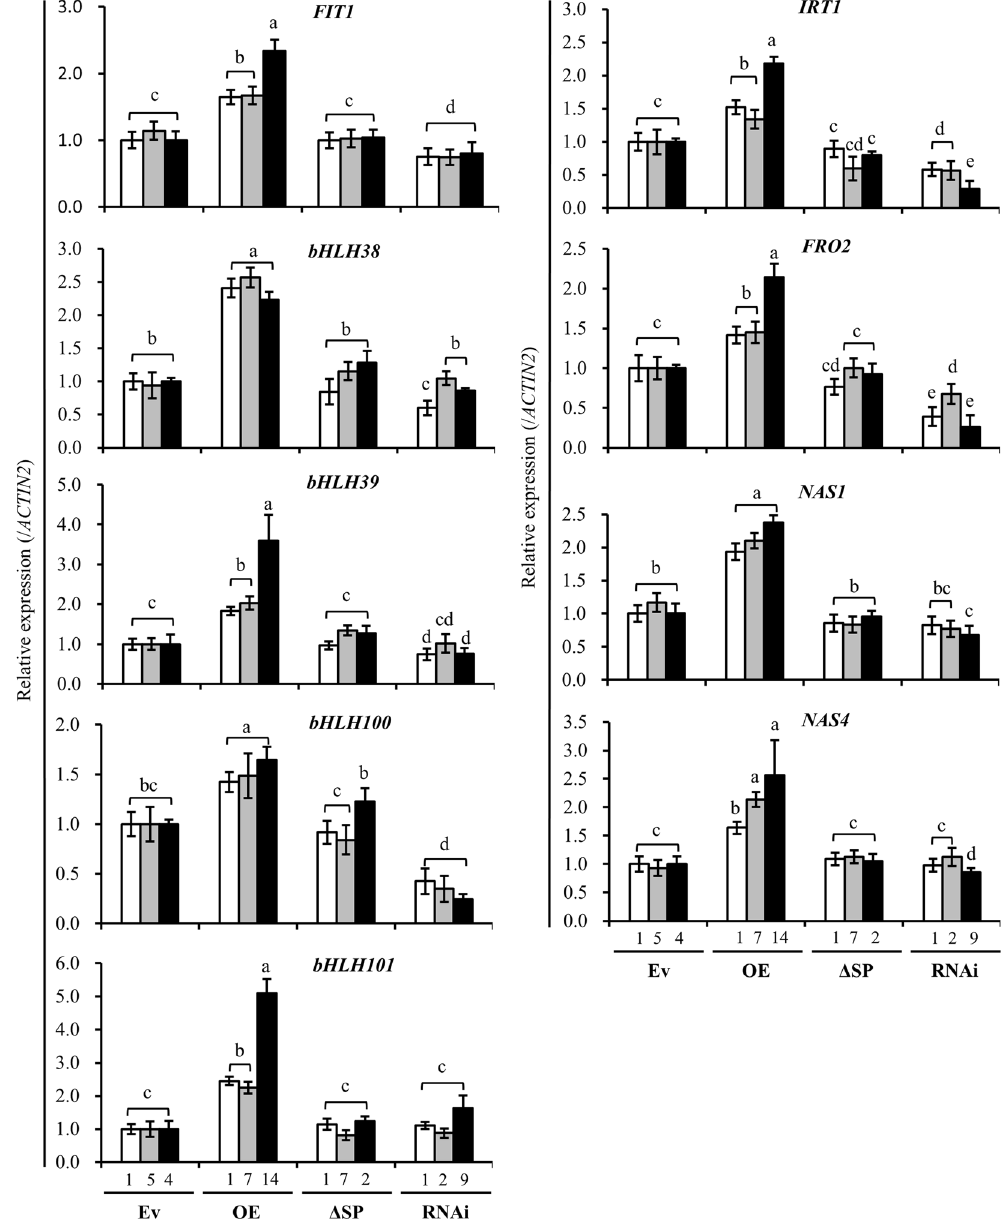
Figure 4. Iron deficiency-associated genes are upregulated in AtPDF1 . 1 OE plants. The leaves and roots were harvested from hydroponically grown transgenic A . thaliana plants (Ev: line 1, 5, 4; OE: line1, 7, 14; Δ SP: line 1, 7, 2; RNAi: line 1, 2, 9) and the expression levels of genes associated with iron homeostasis ( FIT1 , bHLH38 , bHLH39 , bHLH100 and bHLH101 ) in the leaves, and iron deficiency response ( IRT1 , FRO 2, NAS1 and NAS4 ) in the roots were monitored by qPCR and compared with expression in the empty vector control plants (Ev4, defined value of 1). Transcript levels were normalized to those of ACTIN2 . Values are means ± standard errors from twelve samples for each line in a single experiment that was repeated at least three times with similar results. Different letters above each bar indicate significant difference (LSD post hoc one-way ANOVA, P <